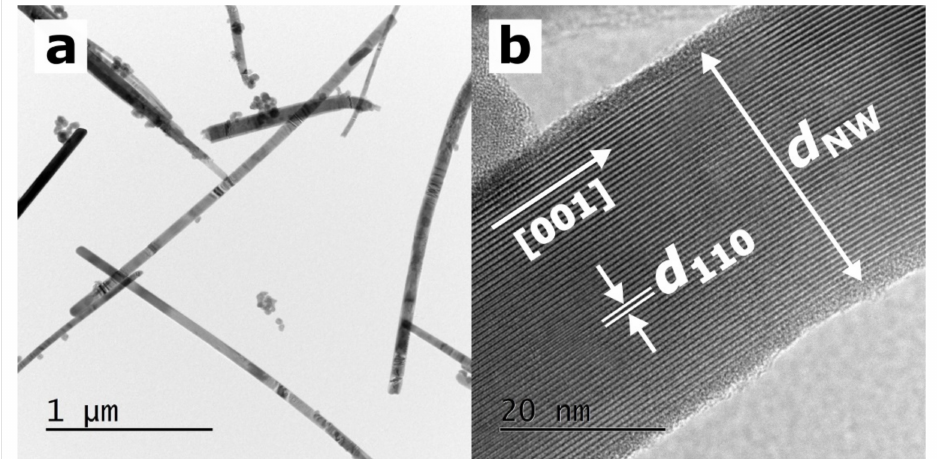
Figure 2. ( a ) TEM micrograph presenting a dozen SbSI nanowires and ( b ) HRTEM image of a selected SbSI nanowire. The white arrows indicate the [001] polar direction, nanowire thickness ( d NW = 33.6(16) nm), and interplanar spacing ( d 110 = 0.6517(20) nm), which corresponds to the inter- planar spacing of (110) planes reported in the literature for SbSI